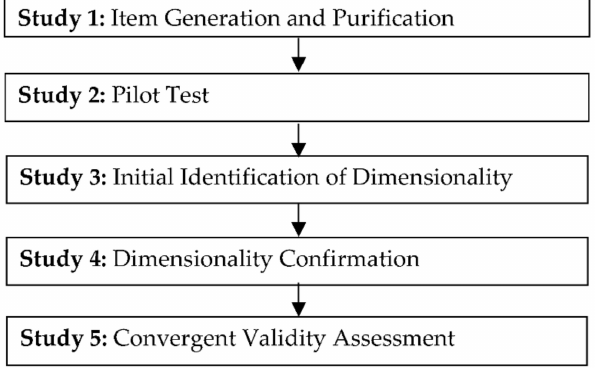
Figure 1. The micro view of research